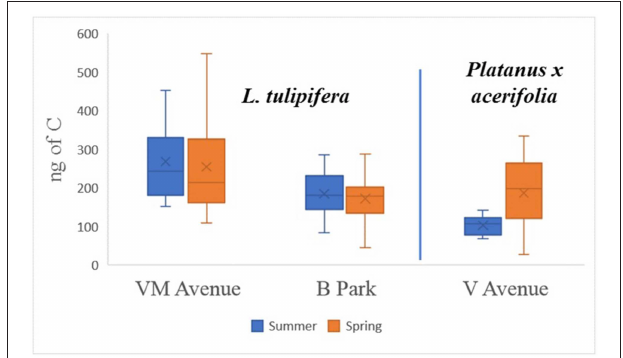
FIGURE 2 | Total concentrations of AVOCs leaf content in L. tulipifera and Platanus x acerifolia at the sampling sites VM Avenue, B Park, and V Avenue, both in summer and in spring. Concentrations are expressed as ng of C. In the boxes: X = arithmetic mean; horizontal line =